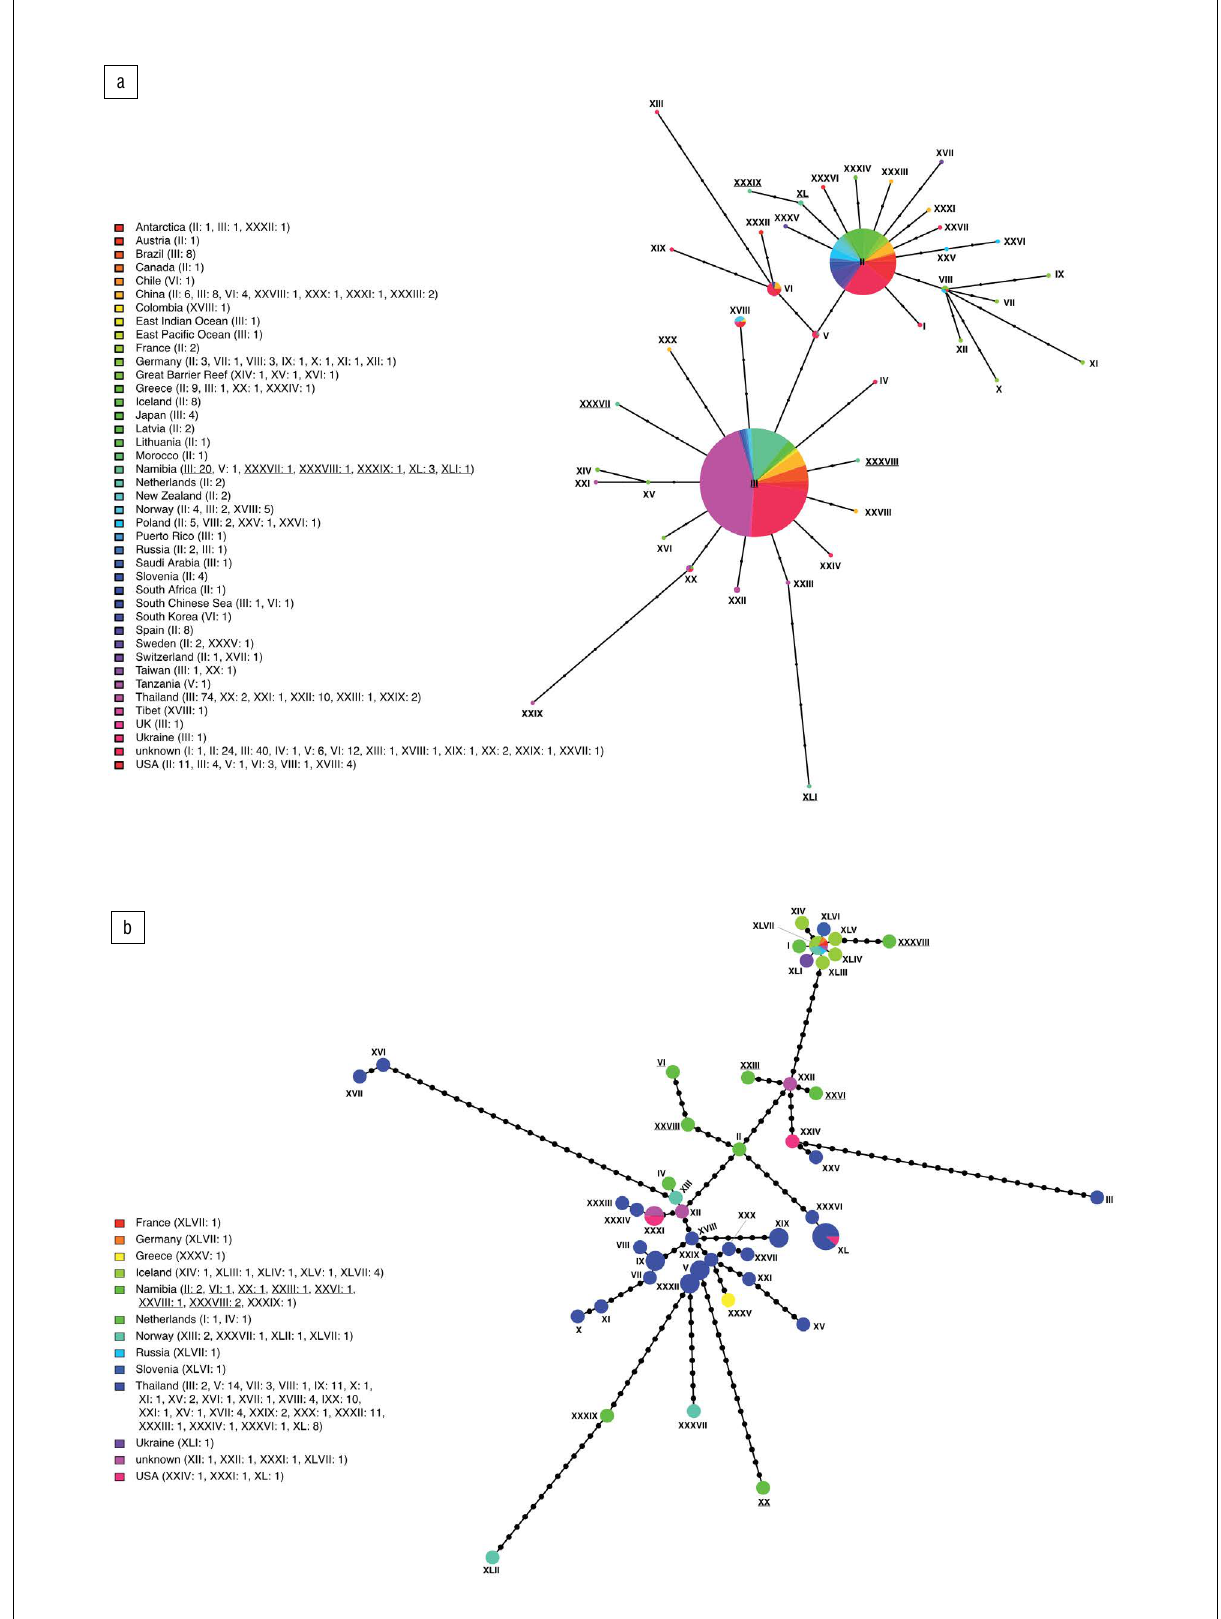
Figure 4: Minimum spanning tree of (a) ITS and (b) beta-tubulin 2 for Aureobasidium sequences. Roman numerals indicate individual haplotypes. Country of origin is colour-coded and the text in parentheses indicates the number of sequences per haplotype per country of origin. Haplotypes containing taxa from this study are